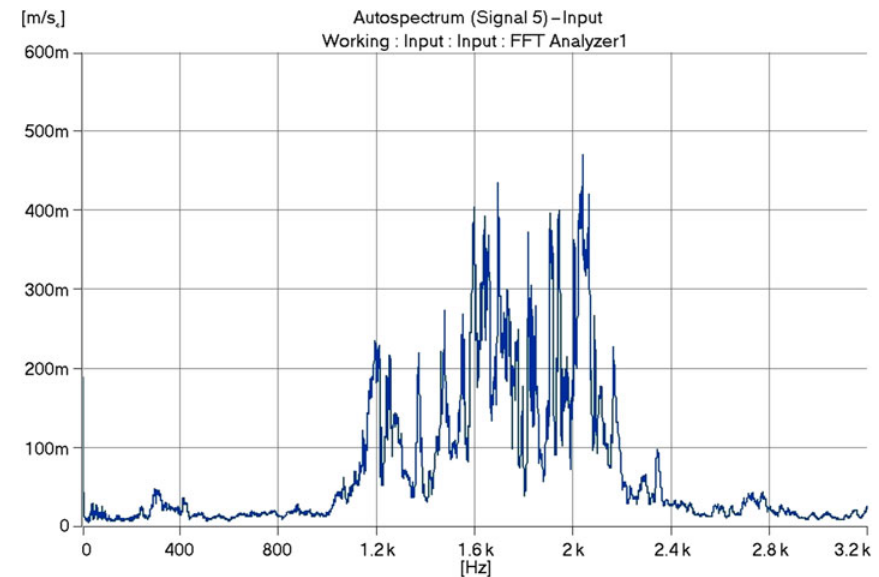
Fig. 10. Autospectrum of Signal 5, vibration of the working press number 2